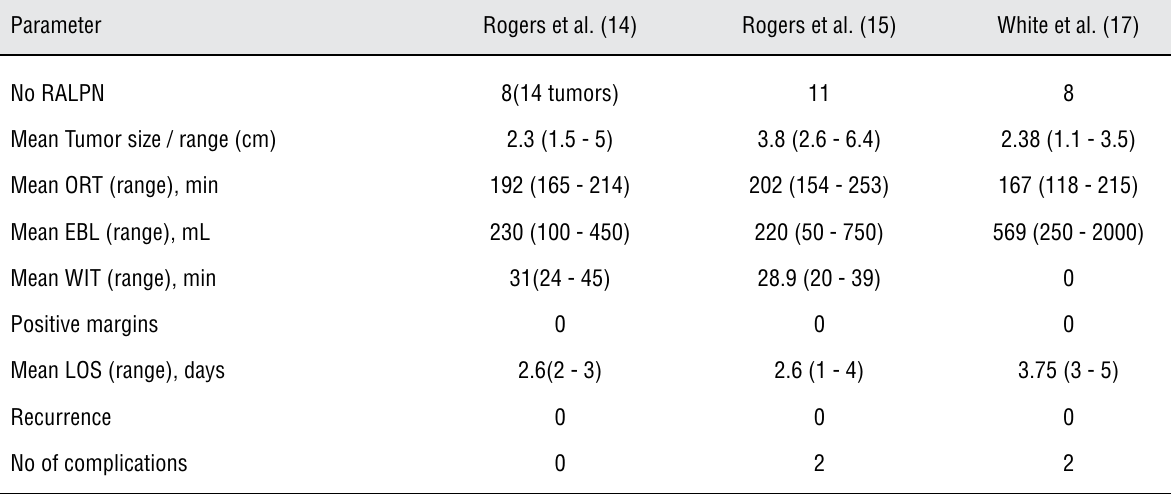
Table 5 - RALPN for complex tumors.